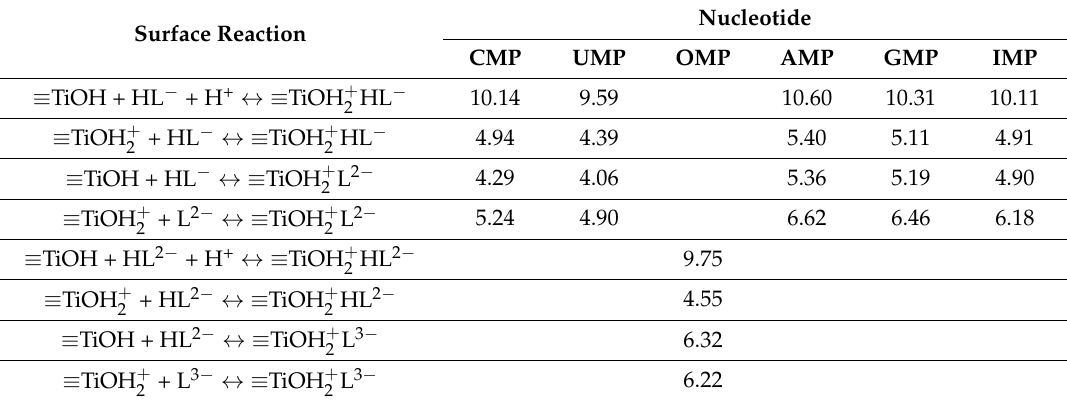
Table 4. Equilibrium reaction and formation constants of nucleotide surface complexes (logK ± 0.05).